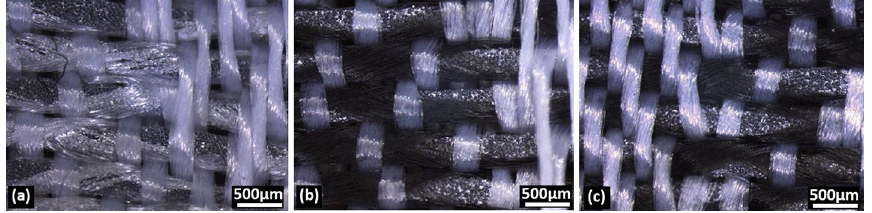
Fig. 8 Microscopic images of sample surfaces at 500 µm: a RF1 with silver reflective threads as weft, b RF2 with black reflective threads as weft and c RF3 with black reflective threads as weft, all in the horizontal plane. RF Reflective